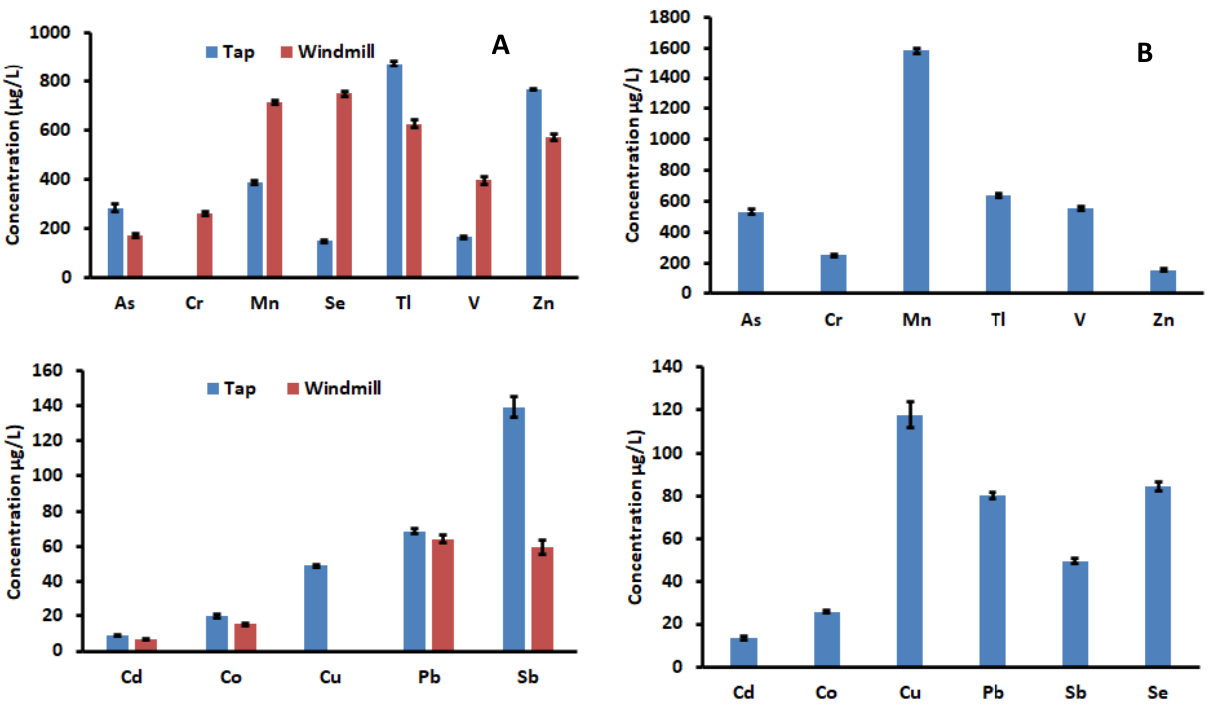
Figure 2. Metal concentrations (µg L −1 ) of trace elements in tap and windmill water samples collected in ( A ) dry and ( B ) wet seasons. Table 4. WQI parameters, WHO desirable limit (2011 weights and relative weights)